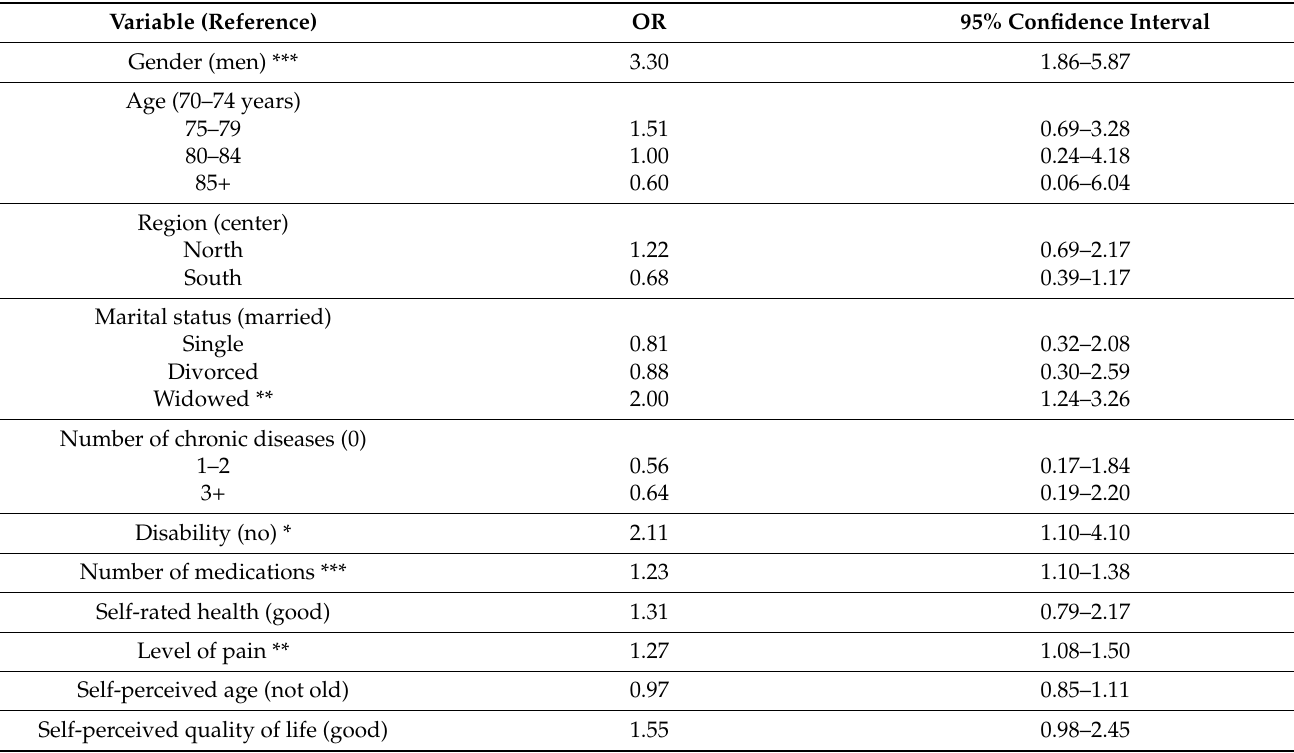
Table 3. Adjusted odds ratio of depression